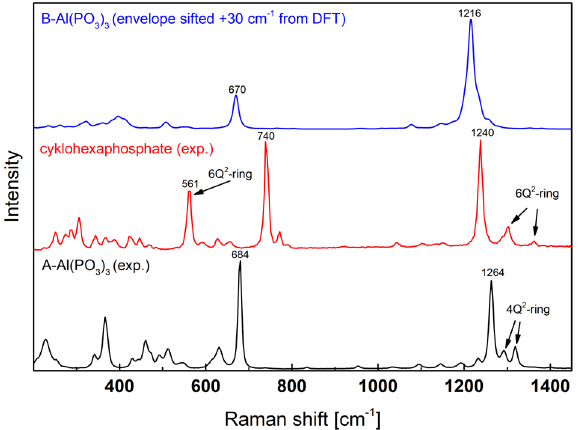
Figure 19. Comparison of experimental spectra of Al(PO 3 ) 3 polymorphs and envelope of calculated spectra of